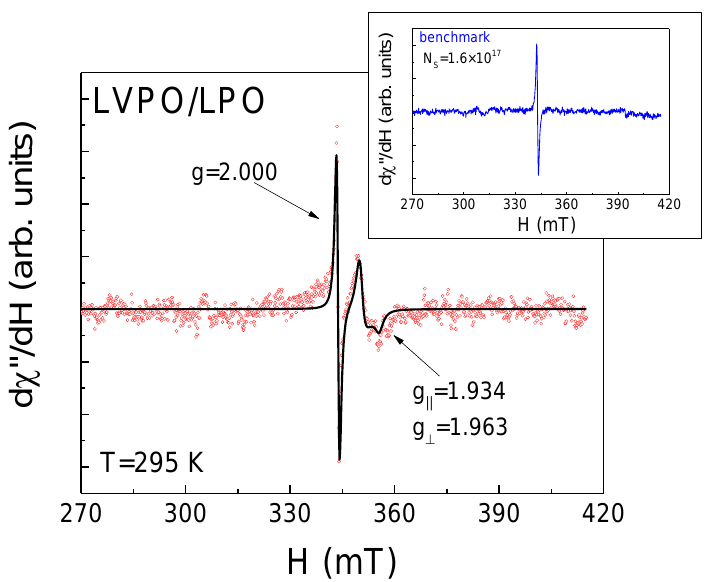
Figure 6. Electron resonance spectrum of the Li 3 V 2 (PO 4 ) 3 /Li 3 PO 4 composite at room temperature at the X-band frequency. Symbols correspond to the experimental data, solid lines indicate fits by the powder sample spectra using the EasySpin software package. Inset shows the electron spin resonance spectrum of the benchmark containing N = 1.6∙× 10 17 magnetic spins.